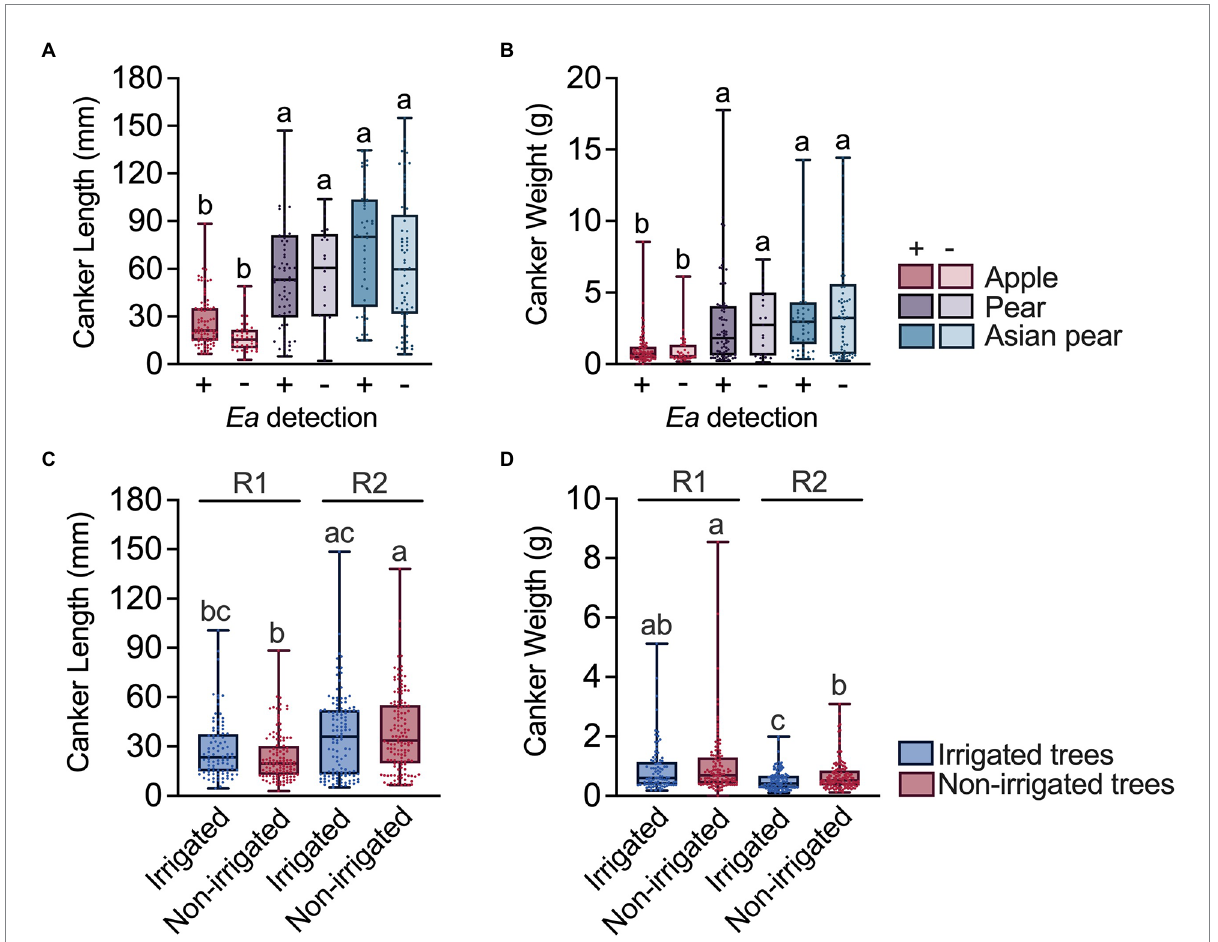
FIGURE 5 Relationship between the canker size and the E. amylovora host species, positive/negative detection of the pathogen in cankers, tree irrigation and the conditions during the experiment. Charts (A) and (B) show differences between the canker sizes in positive (+) and negative ( − ) samples for E. amylovora detection during the first experimental repeat, using apple, pear and Asian pear cankers from non-irrigated trees. Individual data for canker sizes are represented with dots. Boxes and whiskers illustrate the median, first and third quartiles and the range. Charts (C) and (D) compare canker lengths and weights from irrigated and non-irrigated apple trees from two independent experiments (R1, 2016–2017; R2, 2018–2019). In the four charts, each box contains data from cultivars representative of each species: Apple cvs. ‘Cortland’, ‘Cameo’ and ‘Honeycrisp’; pear